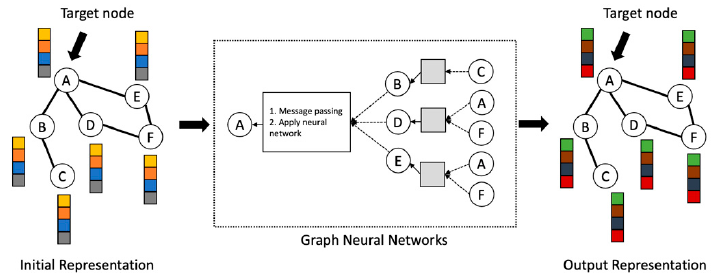
Figure 4. High-level illustration of graph neural network methods.